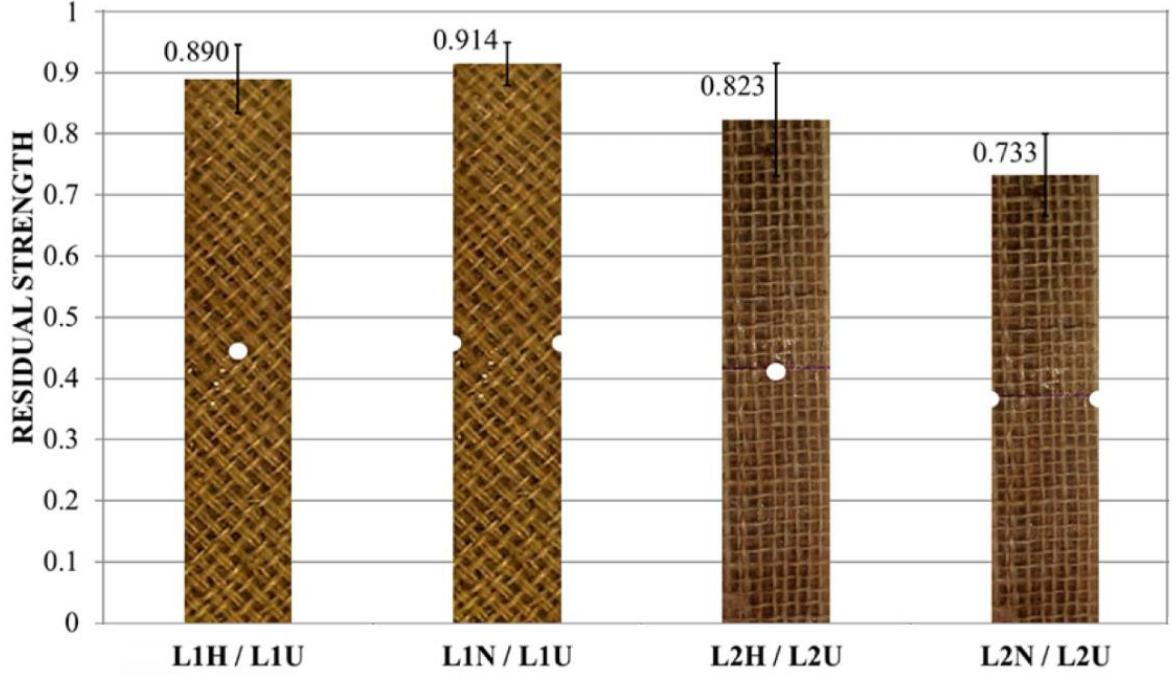
Figure 3. Residual strength for different fiber orientations and positions of a hole [86].